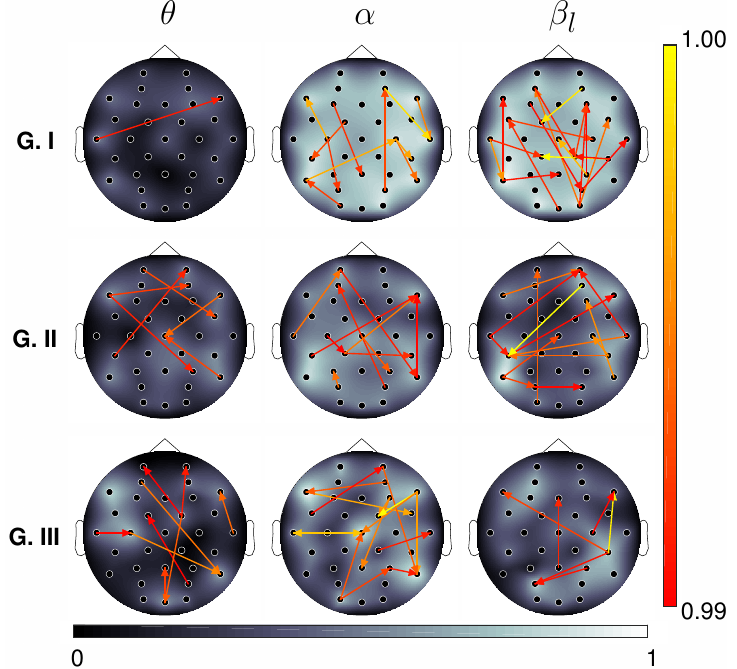
Figure 13. Topoplots of the average node (channel) relevance for each group of clustered subjects and frequency band of interest in the WM database (see Figure 12). The arrows represent the most relevant connectivities for each group. For visualization purposes, only the 1% of the connections, those with the highest average relevance values per group, are